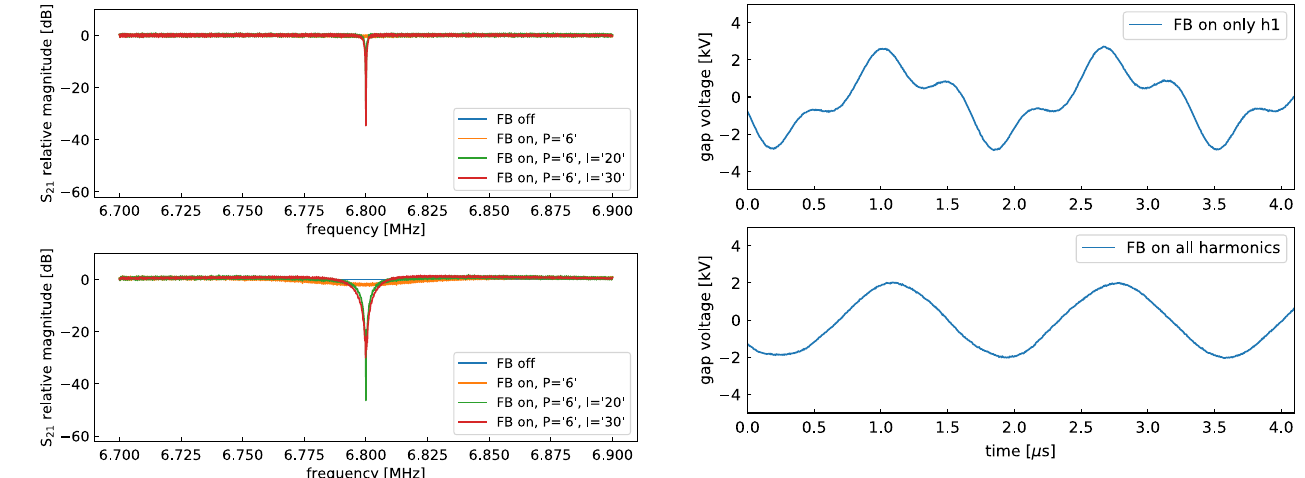
Fig. 25. The maximum amplitude of the second harmonic ( h ¼ 2 ) is 0.1 kV, and the other harmonics are suppressed below 0.05 kV. The voltage waveform is very close to the pure sinusoidal as shown in the bottom plot in Fig. 24.